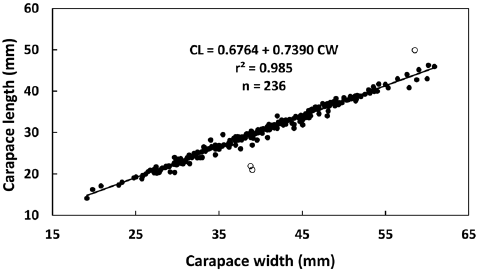
Figure 3. Relationship between carapace length (CL) and width (CW) for Hepatus pudibundus (both sexes) off Sergipe (northeastern Brazil) in March/2015–May/2016. White circles represent outliers.